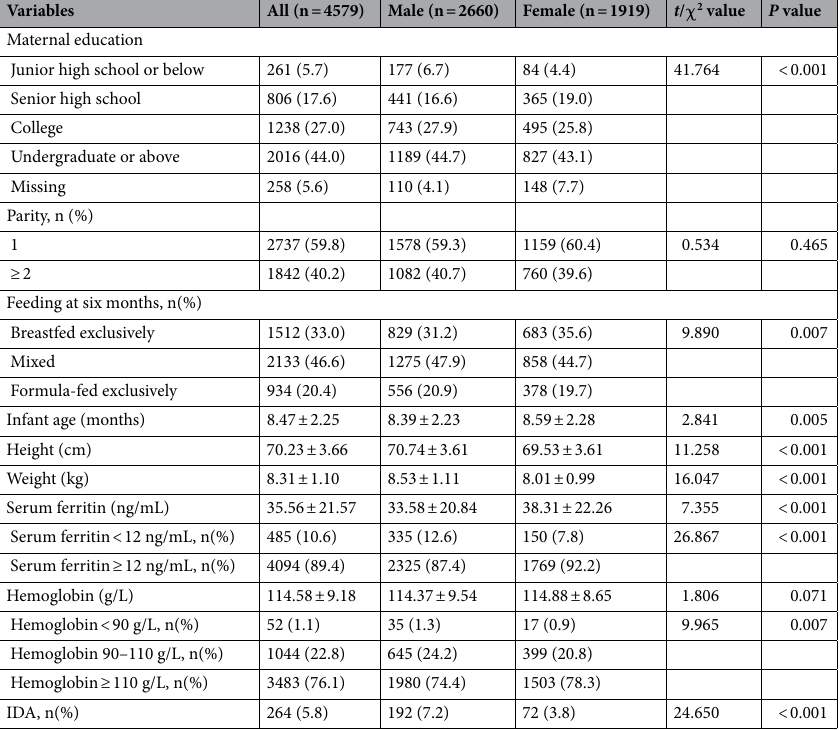
Table 1. Characteristics of the infants (n = 4579). Values are presented as the mean ± SD or n(%). Differences between the male and female groups were explored using the t-test or chi-square test. IDA, iron deficiency